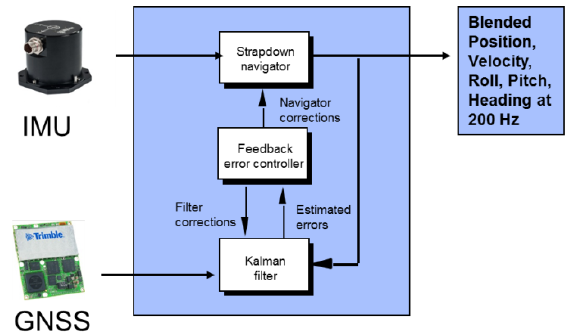
Figure 1: GNSS-Aided Inertial